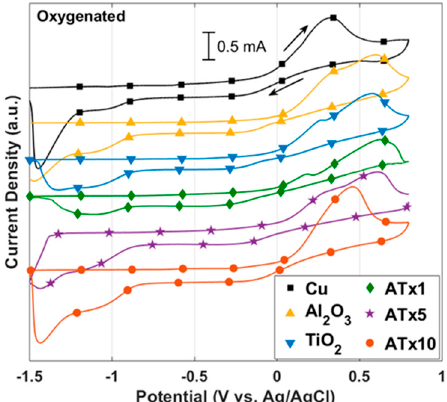
Figure 13. I–V curves in oxygenated 0.1 M NaCl for coated and uncoated copper, measured at a scan rate of 10 mV/s. Arrows indicate the scan direction.